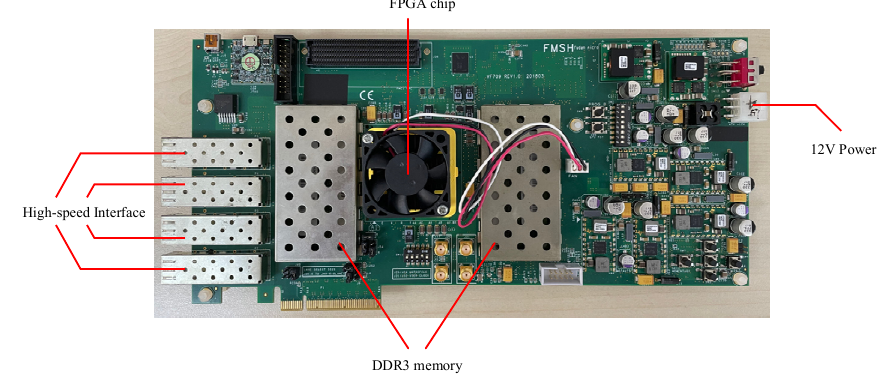
Figure 15. FPGA processing board for the experiment.